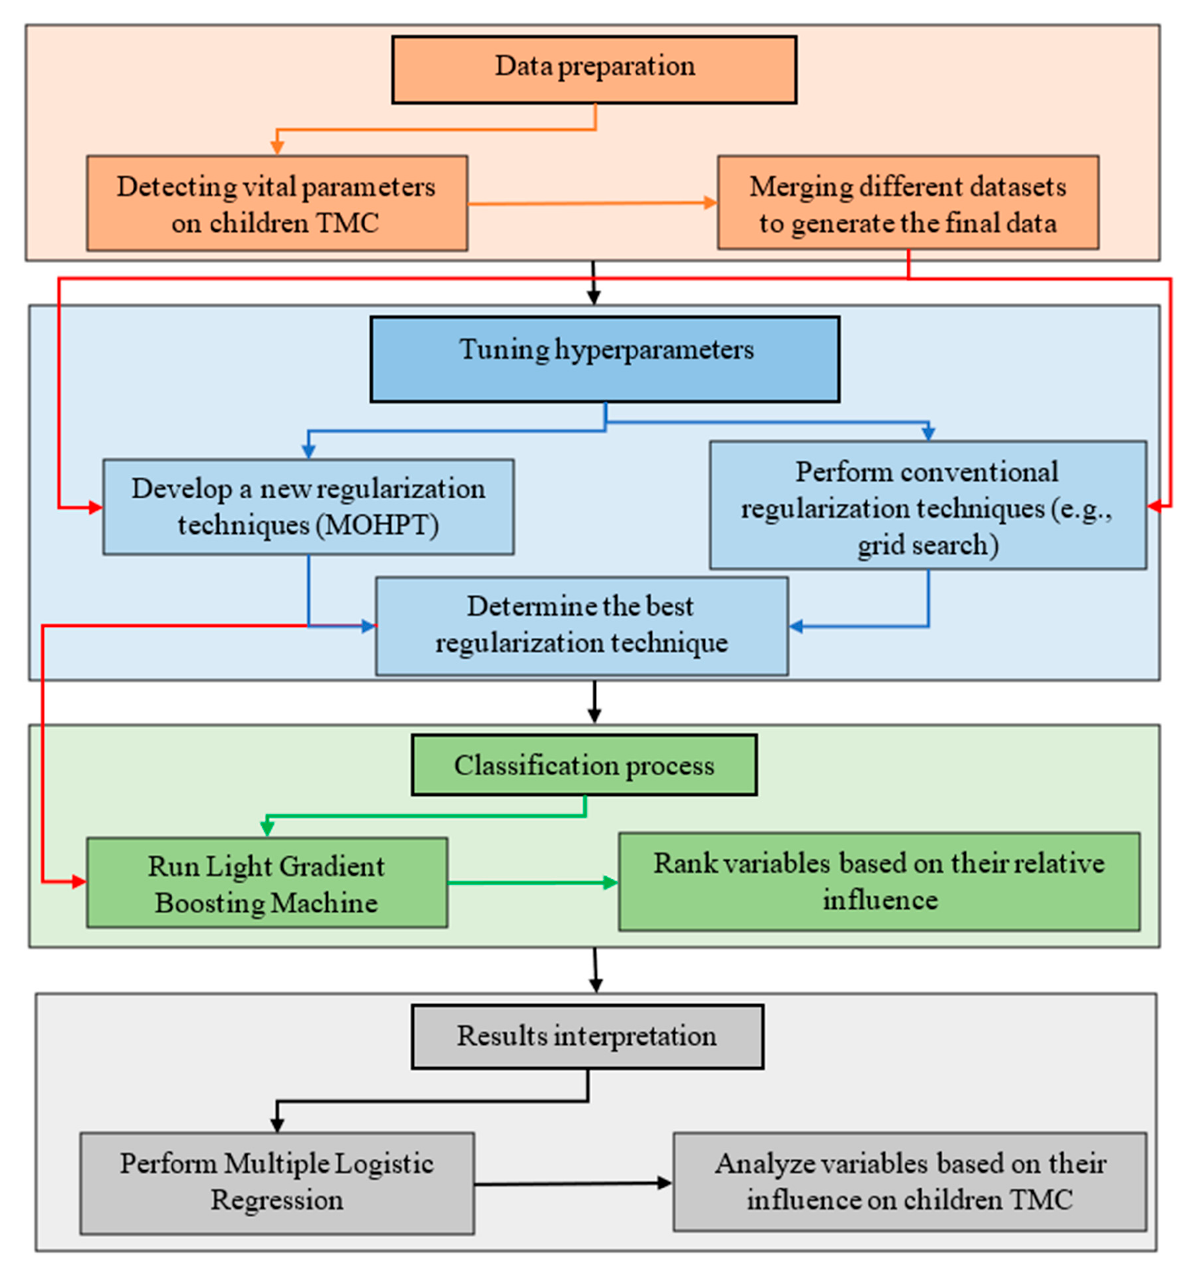
Figure 1. The flowchart of the methodology.